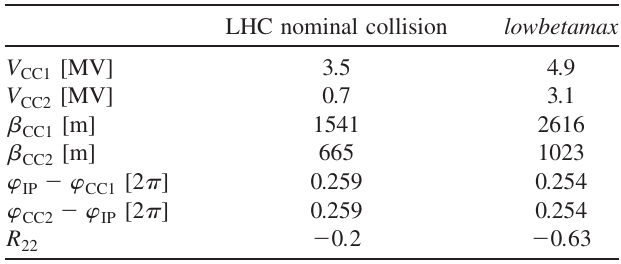
TABLE II. Local crab-cavity voltage for LHC nominal colli- sion optics and lowbetamax collision optics.